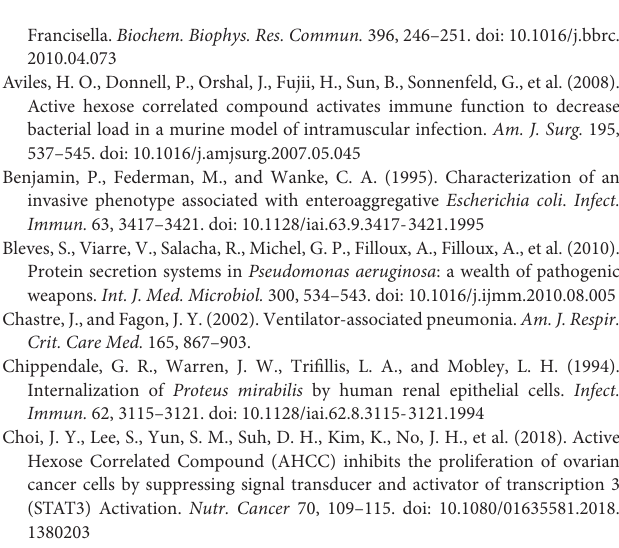
Supplementary Figure 1 | Formation of P. aeruginosa biofilm. Biofilm formation in the absence and in the presence of different concentrations of AHCC R (cid:13) at 8 h in glass test tube and 24-well plates. Supplementary Figure 2 | Toxicity of AHCC R (cid:13) on macrophage cells. Macrophage cell was exposed to kit reagent (LDH positive compound) and AHCC R (cid:13) at 2 and 5 mg/of final concentration. Following incubation at 37 ◦ C for 24 h, the LDH activity was determined as described in Materials and Methods. ∗ p < 0.05